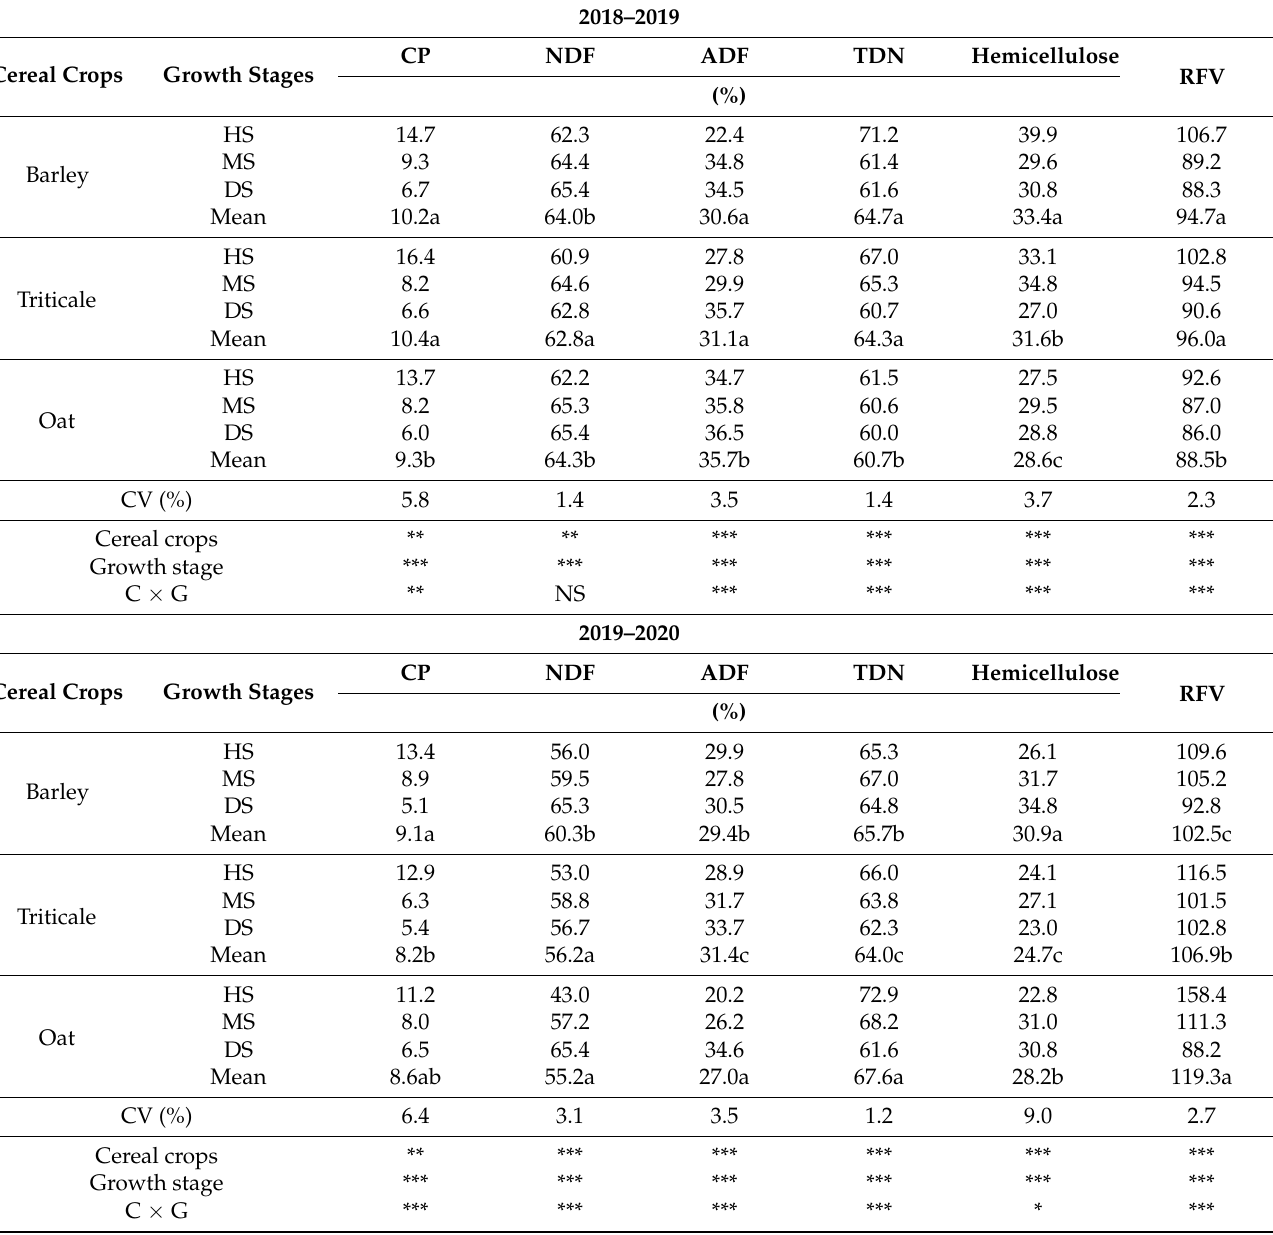
Table 4. Chemical composition according to the growth period of three winter cereals for two